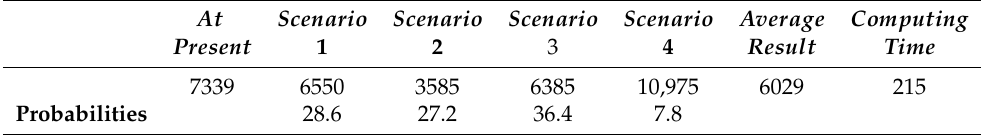
Table 7. Mean value of waiting minutes on Monday, 11 January 2021, waiting time in the randomized experiment realizations, probabilities of each scenario, actual waiting time and computation time (s).